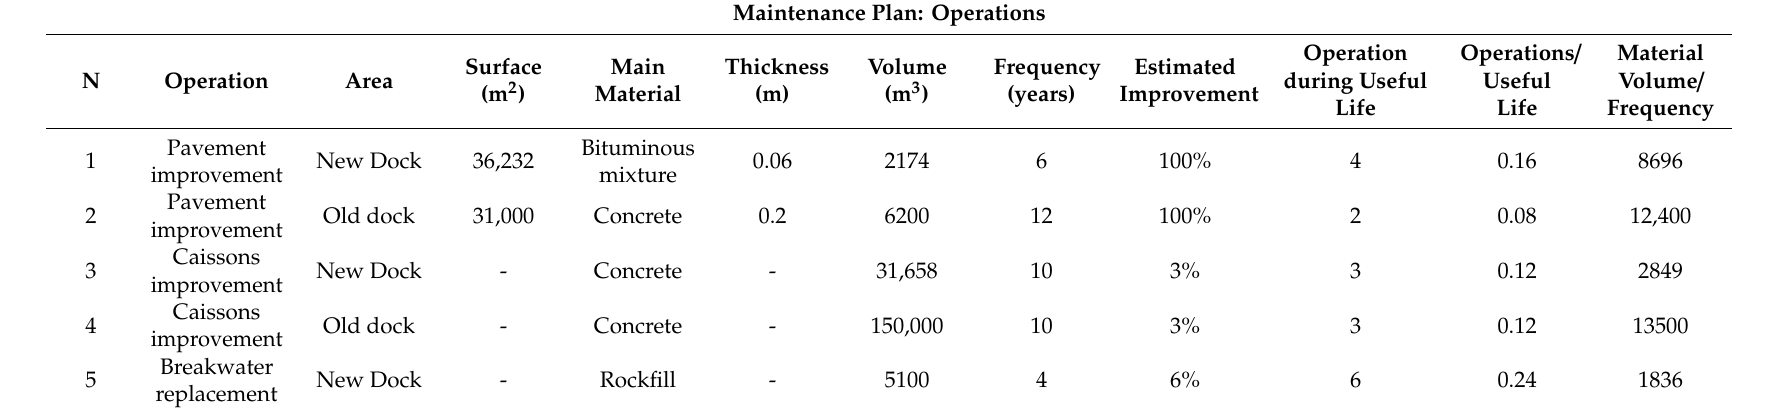
Table 3. Inspections and action during the maintenance